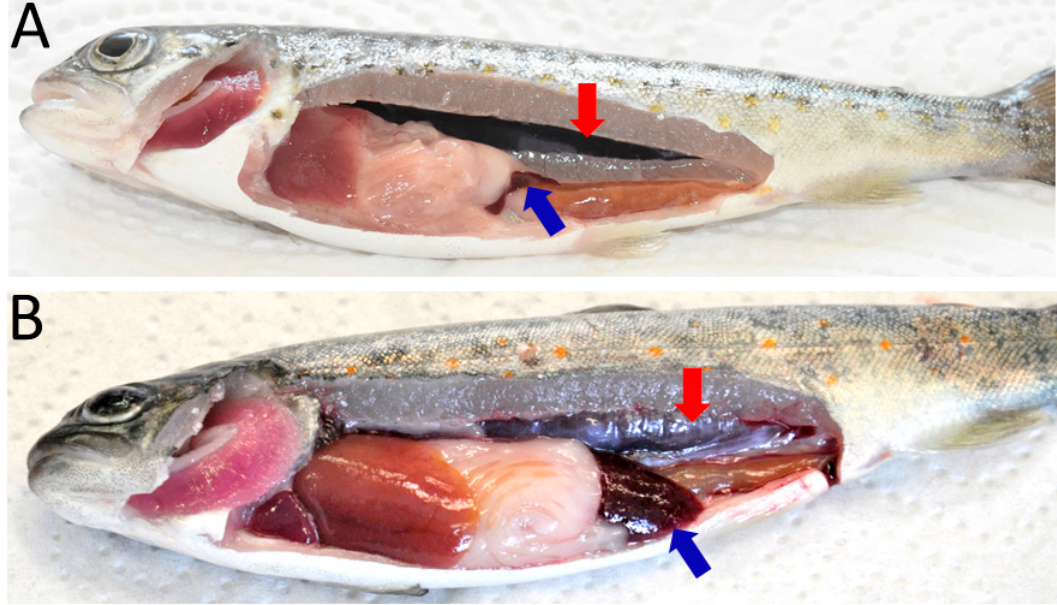
Figure 1. Clinical manifestations of proliferative kidney disease in brown trout. ( A ) Control fish showing normal kidney and spleen; ( B ) infected fish showing renal hyperplasia (enlargement of kidney) and splenomegaly (enlargement of spleen). Red arrow: kidney, blue arrow: spleen.